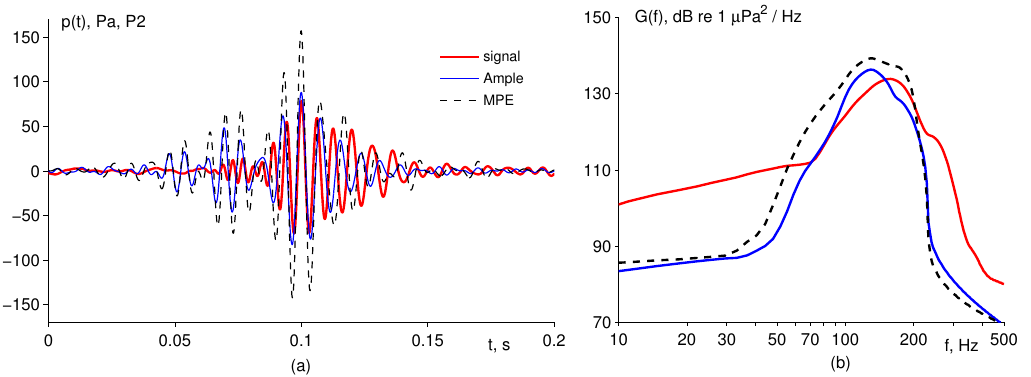
Figure 7. Comparison of filtered experimental and model pulse signals at the reception point P2 ( a ) and their spectra ( b